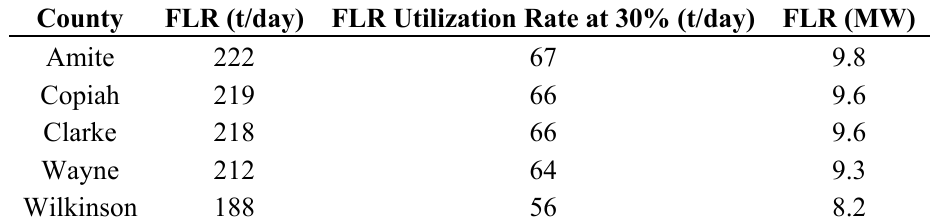
Table 1. Top 5 Mississippi counties in terms of available forest logging residue and their potential CHP capacities.